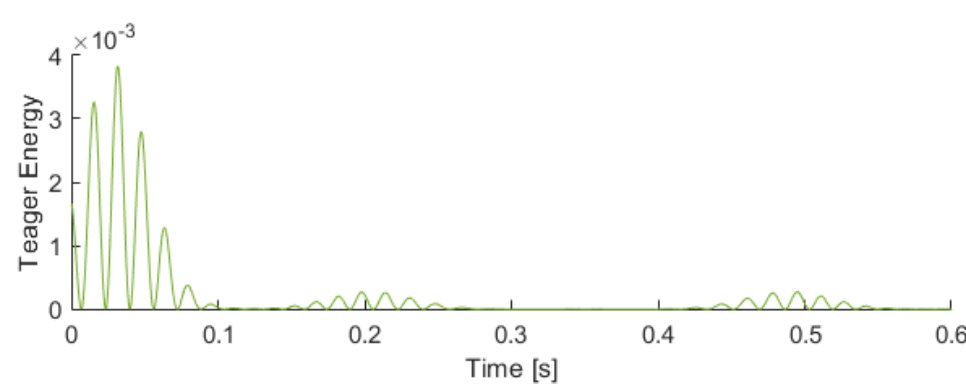
Figure 6. Energy of the rotor with one broken bar—1 BAR (filter centered at f 0 = 30 Hz).